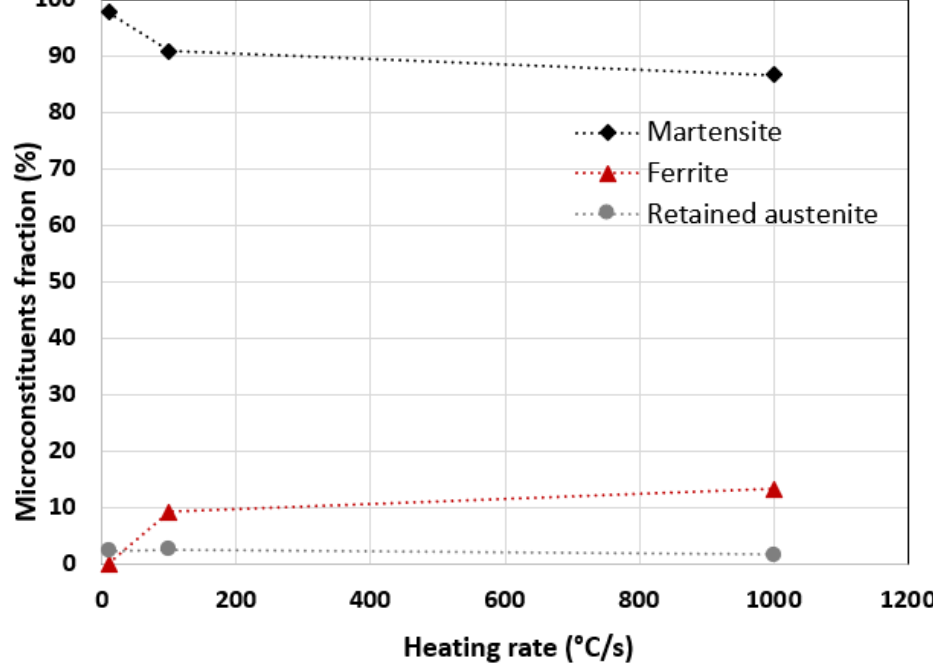
Figure 14. Microstructural evolution at different HRs for peak temperature at 915 °C (data from [57]; steel chemical composition: 0.2% C + Mo + Ti + Nb).